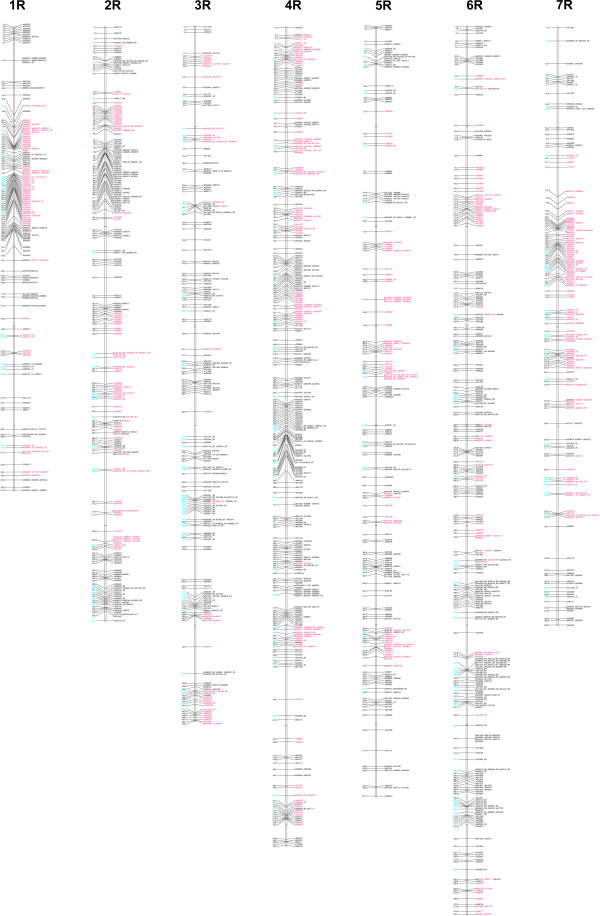
Genetic linkage map of the cross L318xL9 containing 1818 loci. Loci with distorted segregations at p < 0.01 are indicated by asterisks and shown in red. DArT markers with chromosomal location determined using addition lines are indicated by the symbol of the respective chromosome added after underscore, their map locations are shown in blue.